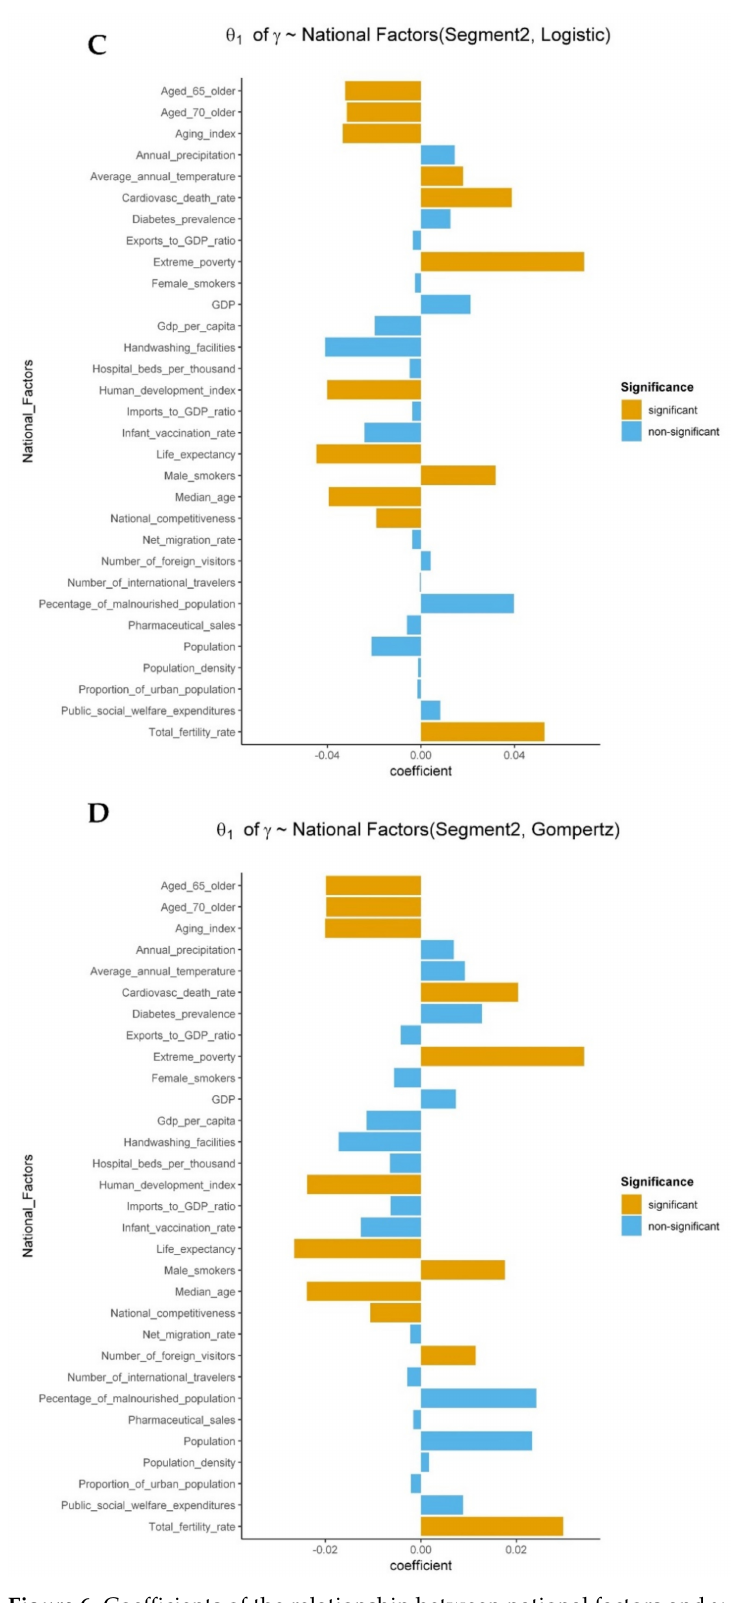
Figure 6. Coefficients of the relationship between national factors and γ . θ 1 is the coefficient of the relationship between a national factor and a GCM parameter. Significant national factors (orange) had large coefficients compared with non-significant factors (blue) in both Gompertz ( A , C ) and logistic models ( B , D